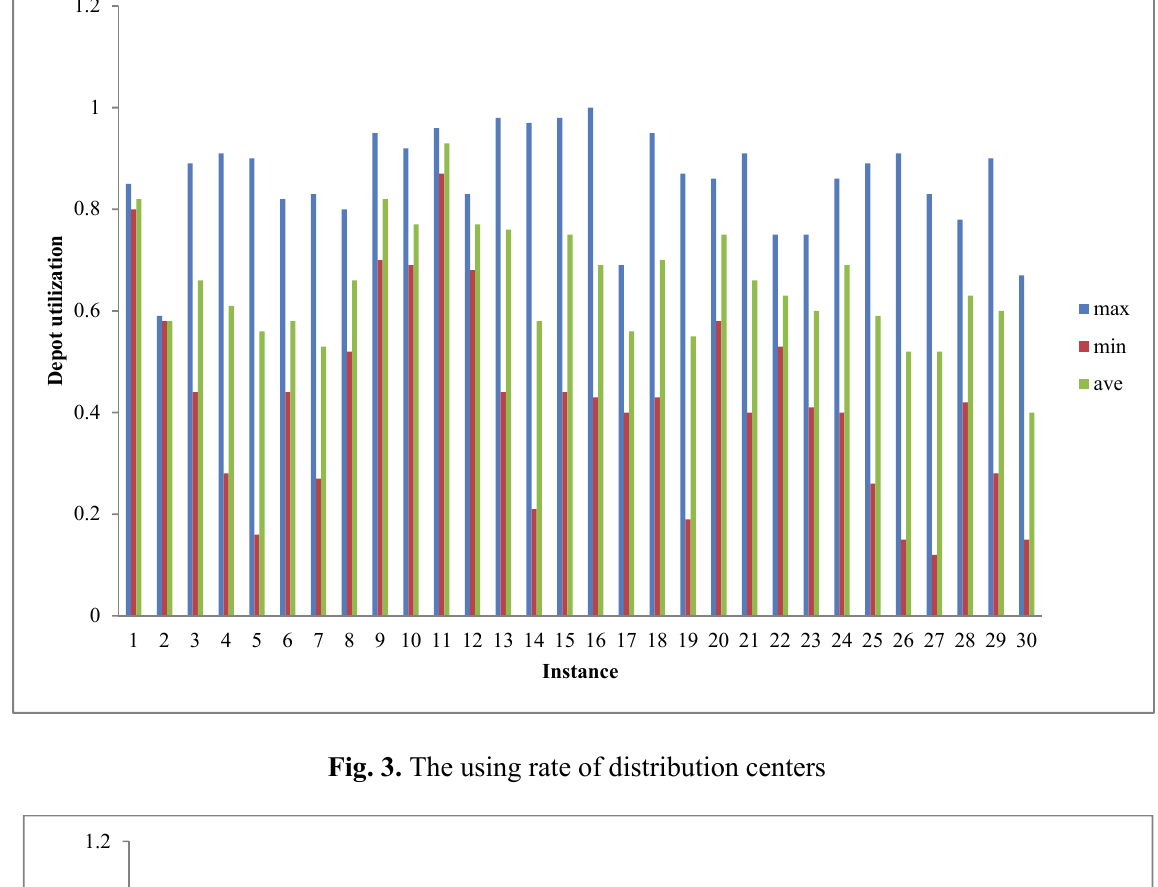
Fig. 3. The using rate of distribution centers